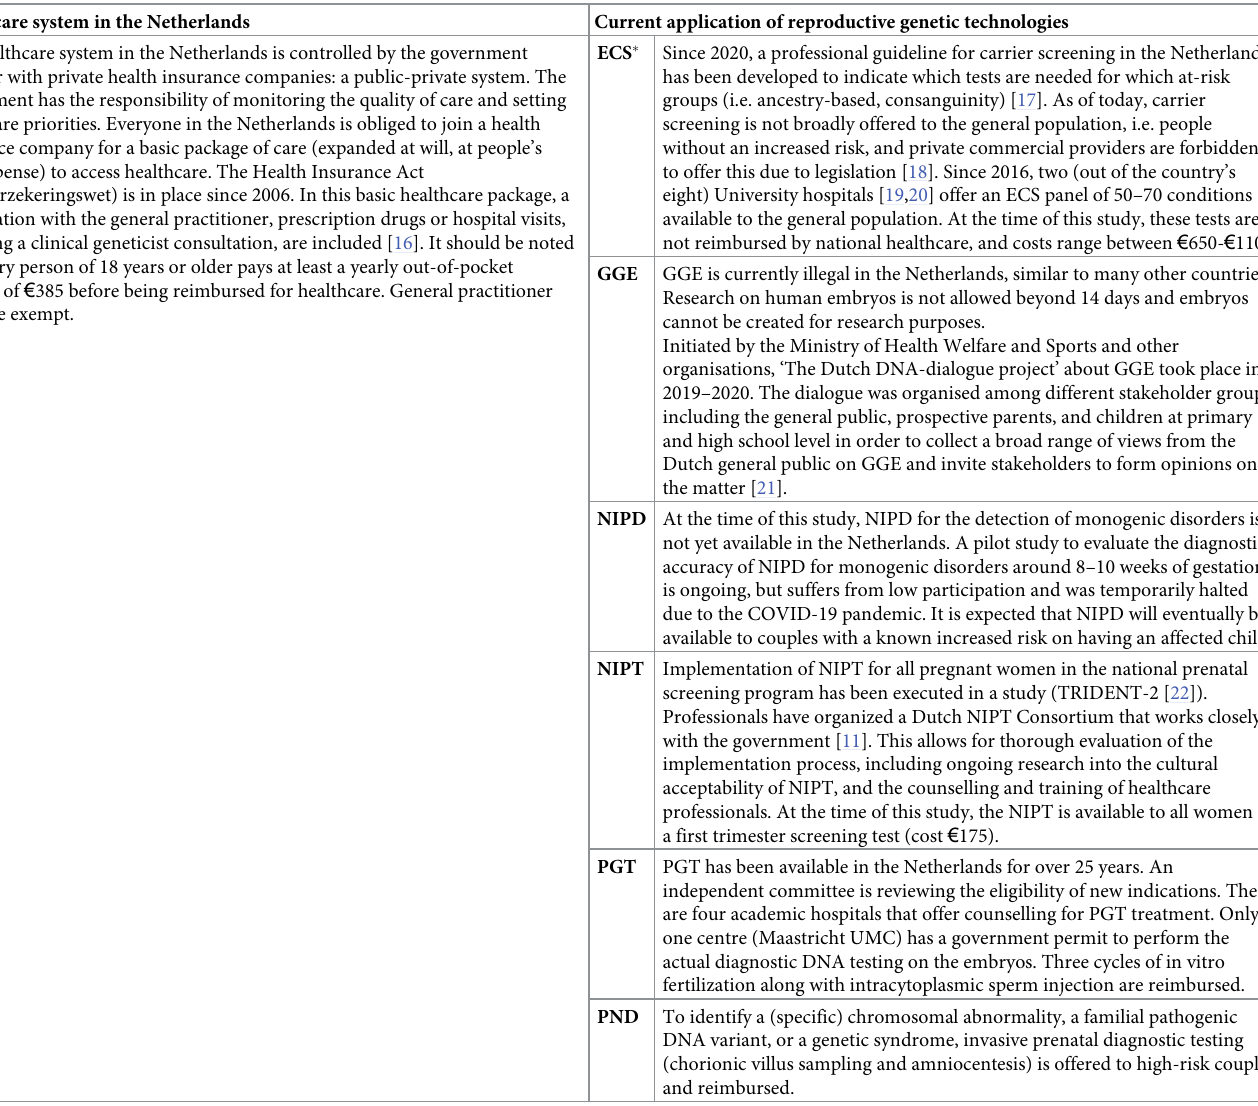
argues that a (healthcare) system can be seen as a constellation of interrelated practices and rel- evant structuring elements, and can be described by its (i) structure (organizational and power structures), (ii) culture (values and thinking) and (iii) practice (actions and implementation) (Fig 1). According to this model, actors (stakeholders) determine structure and culture. Actors are known to generally be hesitant to change, for example to adopt a new technology that is (not yet) concordant with the structure or culture of the existing system. When new technolo- gies are developed and implemented in an existing (healthcare) system, transition occurs when fundamental changes in all three aspects of the system happen. Key actors in the field can either hinder or facilitate change, and act as change agents [3,24].